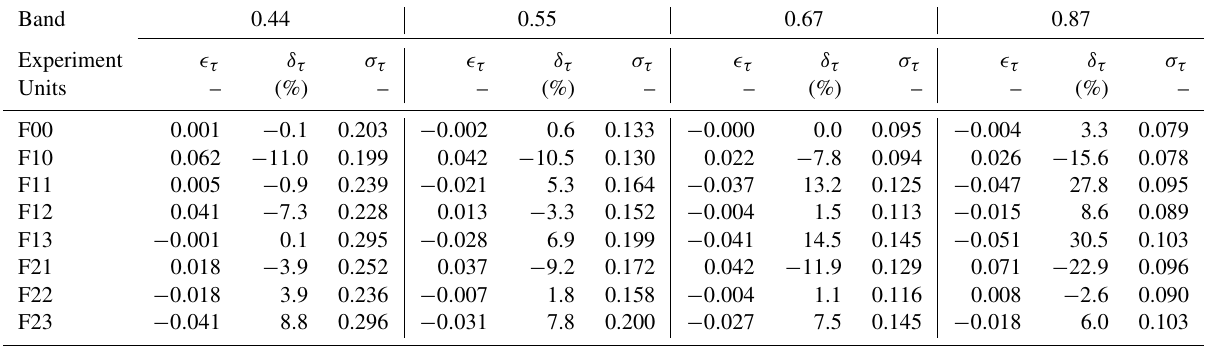
Table 6. Retrieved AOT error and uncertainties for the six experiments. The error (cid:15) τ is calculated as the difference between the retrieved and the true values, δ τ is the relative error in percent and σ τ is the retrieval uncertainty estimated with Eq. (21). Wavelengths are given in µm. Band 0.44 0.55 0.67 0.87